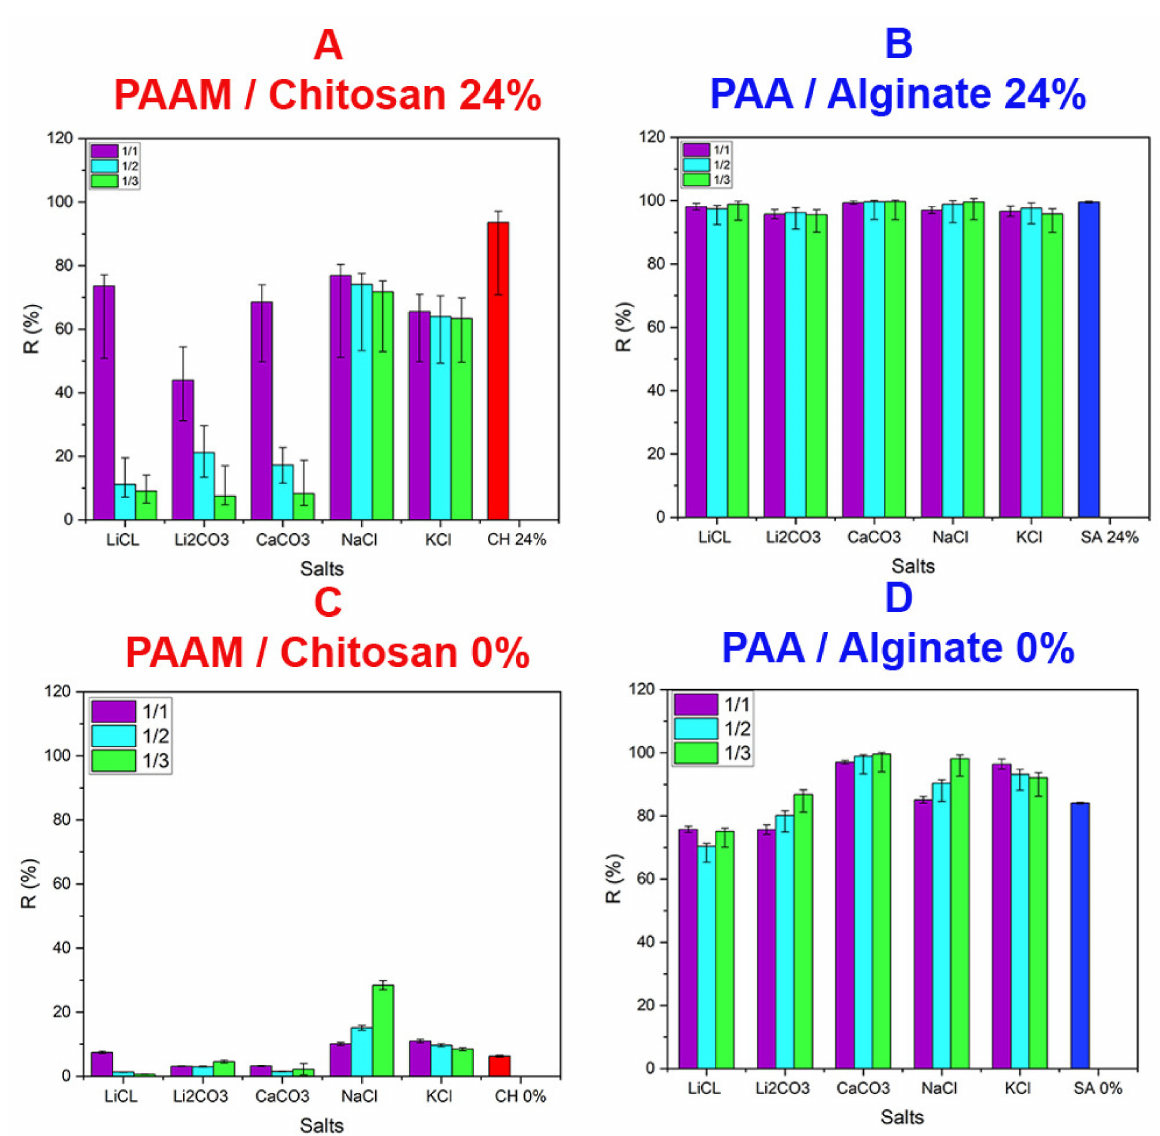
Figure 12. Effect of interfering ions on dye removal for the following salts: LiCl, Li 2 CO 3 , CaCO 3 , NaCl, and KCl, using 1/1, 1/2, and 1/3 molar ratios with dyes. ( A ) Adsorption removal efficiency for PAAM/chitosan 24% xerogel (0.05 g) with MO (100 mg/L) at pH 3.0. ( B ) Adsorption removal efficiency for PAA/Alginate 24% xerogel (0.05 g) with MB (500 mg/L in pH 8.5). ( C ) Adsorption removal efficiency for PAAM/chitosan 0% xerogel (0.05 g) in the presence of salts with MO (100 mg/L) at pH 3. ( D ) Adsorption removal efficiency for PAA/Alginate 0% xerogel (0.05 g) in the presence of salts with MB (500 mg/L) at pH